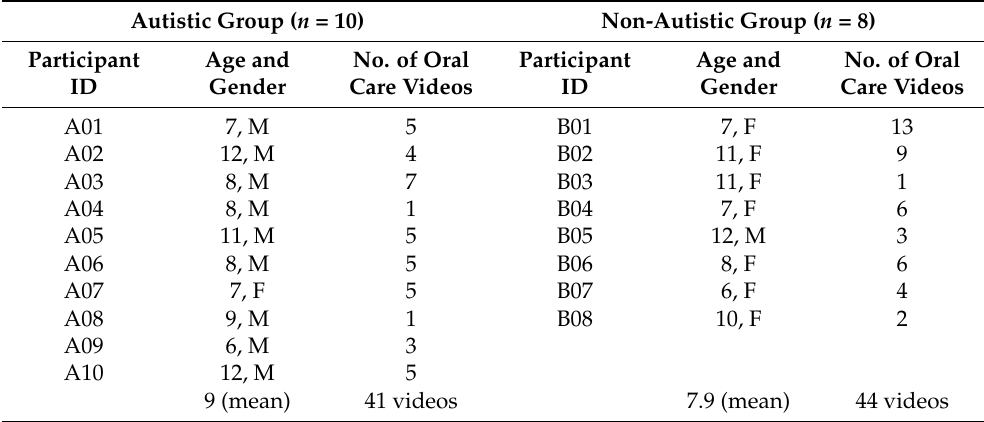
Table 2. Participant age, gender, and video information.